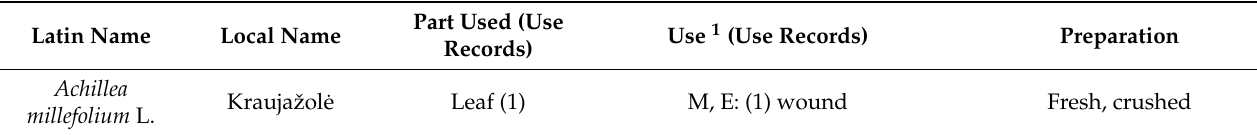
Table 2. Medicinal (M) and veterinary (V) uses of wild and cultivated plants in the south-western part of Lithuania. The data were collected from interviews with 30